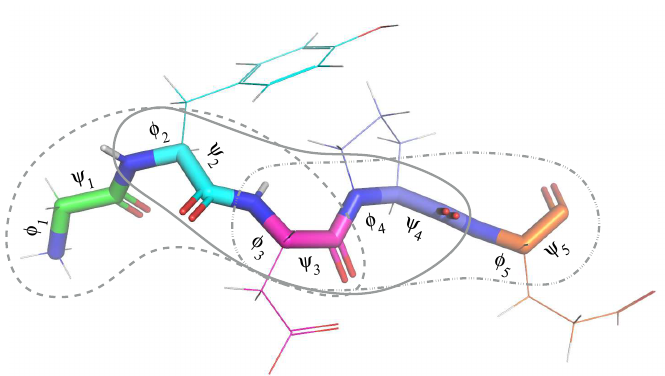
Figure 6. Illustration of a protein fragment involving five residues. Each residue is represented using a different colors for the carbon atoms. The backbone is represented using thicker lines. Considering constant bond lengths, bond angles and peptide bond torsions, the protein backbone conformation can be defined from a pair of angles ( φ and ψ ) for each residue. The gray lines indicate the three overlapping tripeptides composing this five residue